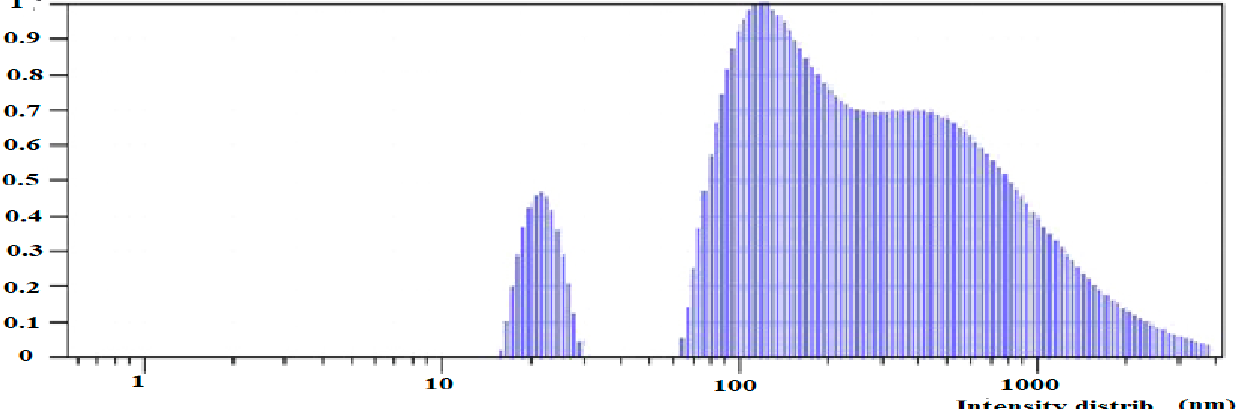
Figure 5. Silicon particle size distribution of freshly prepared colloidal solution.